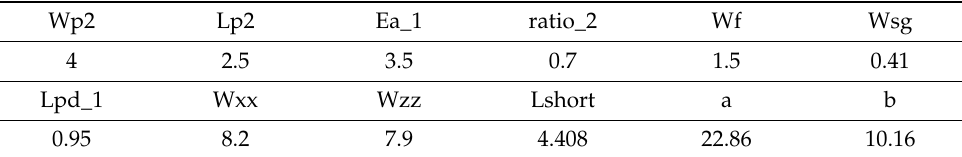
Table 2. Structure parameters of the transition with RT/Duroid 5880 substrate (unit: mm). Wp2 Lp2 Ea_1 ratio_2